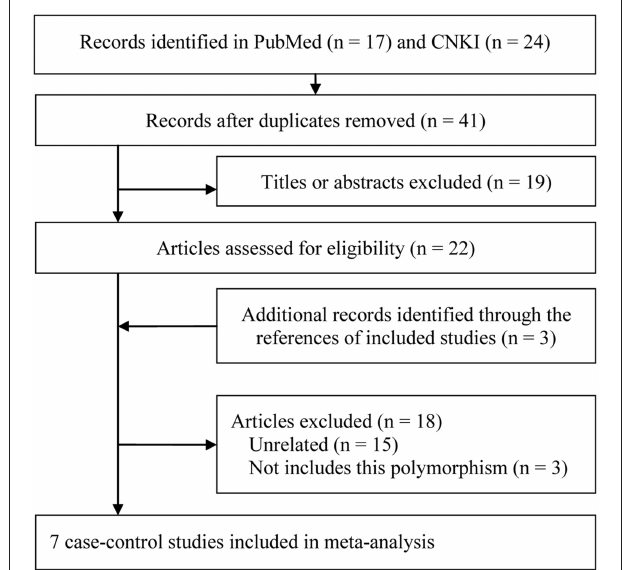
FIGURE 1 | Study selection flow